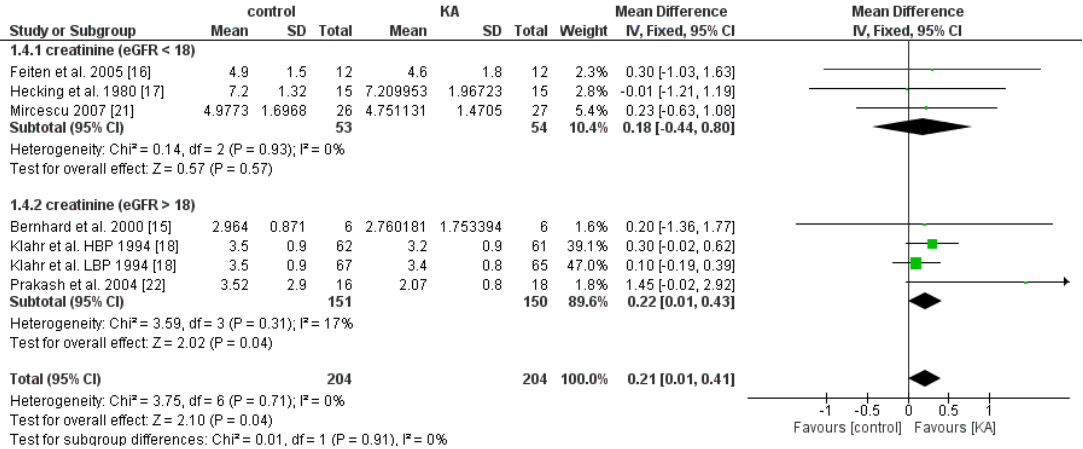
Figure 4. Forest plot of effects of KA on eGFR in CKD patients sub-grouped by eGFR. The random- effects model was utilized.